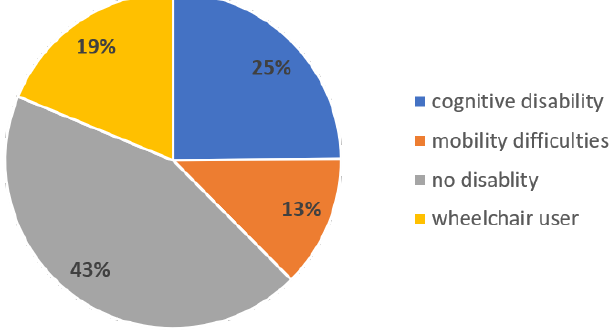
Figure 3. The classification of people who responded to the